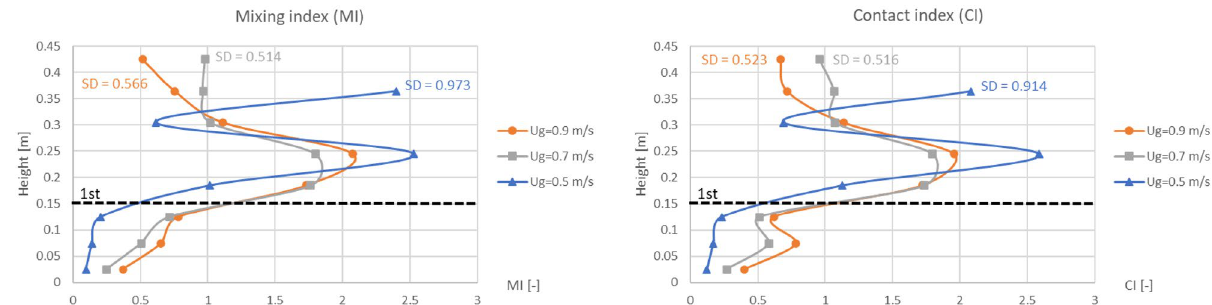
Figure 17. Effect of gas inlet velocity on time-and-area-averaged vertical mixing index (left) and contact index (right) in case of the baffled gasifier with biomass feeding at